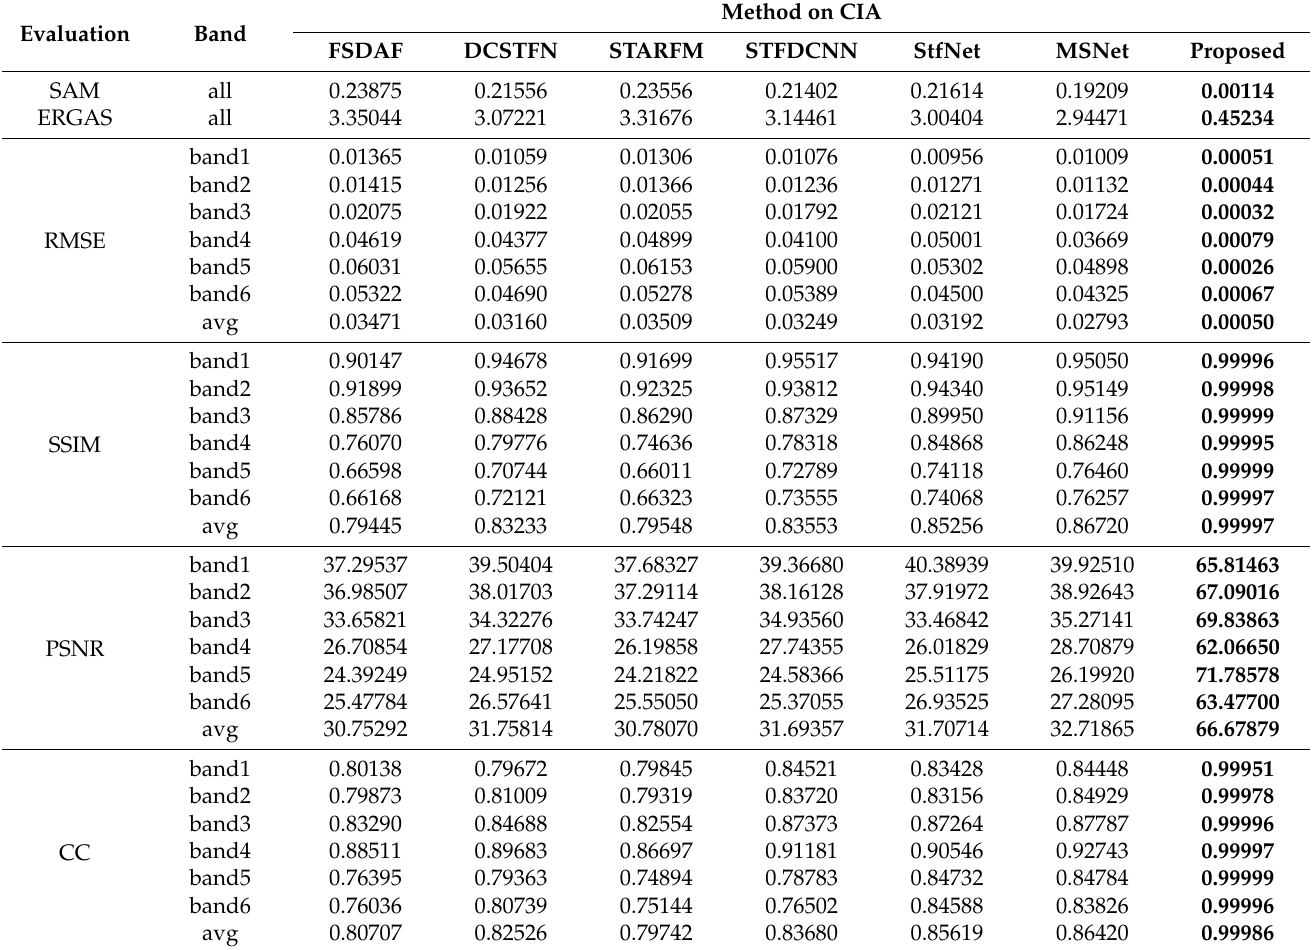
Table 1. Quantitative assessment of various spatiotemporal fusion methods for CIA dataset.